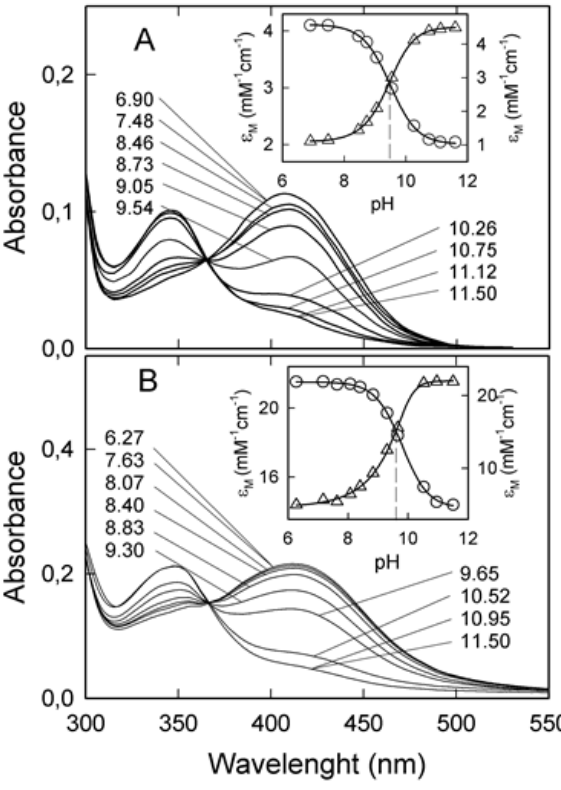
Figure 4: Absorption spectra of the PLP-form enzymes, PSAT-BALC (A) and PSAT-BCIRA (B) at pHs indicated in the figure. Changes in the molar absorptivities at 345 nm (○) and 410 nm (∆) for PSAT-BALC (A); and 348 nm (○) and 412 nm (∆) for PSAT-BCIR (B) are plotted against pHs in the insets. Solid lines in the inset are the theoretical curves, obtained by equation 4 (see Results). The internal aldimine showed pK values at 9.4 for PSAT-BALC (A) and 9.5 for PSAT-BCIRA (B). The buffers were 100 mM Bis-Tris-propane (pH 5.9 - 9.6) and CAPS (pH 10.4 - 11.6). Distinct isosbestic points show that only two species are involved.